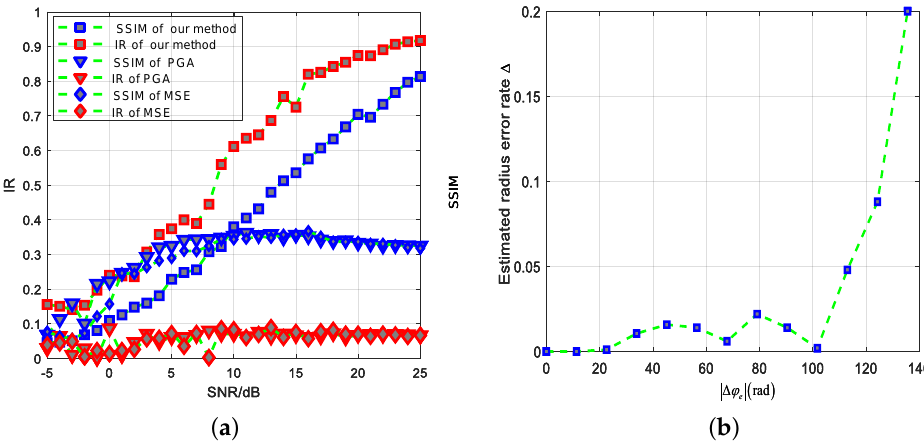
Figure 13. Performance of our proposed method under the impact of two different nonideal factors in the simulation experiment. ( a ) The image relevance and structural similarity curves with different SNRs. ( b ) The estimated radius error rate curve with different levels of motion